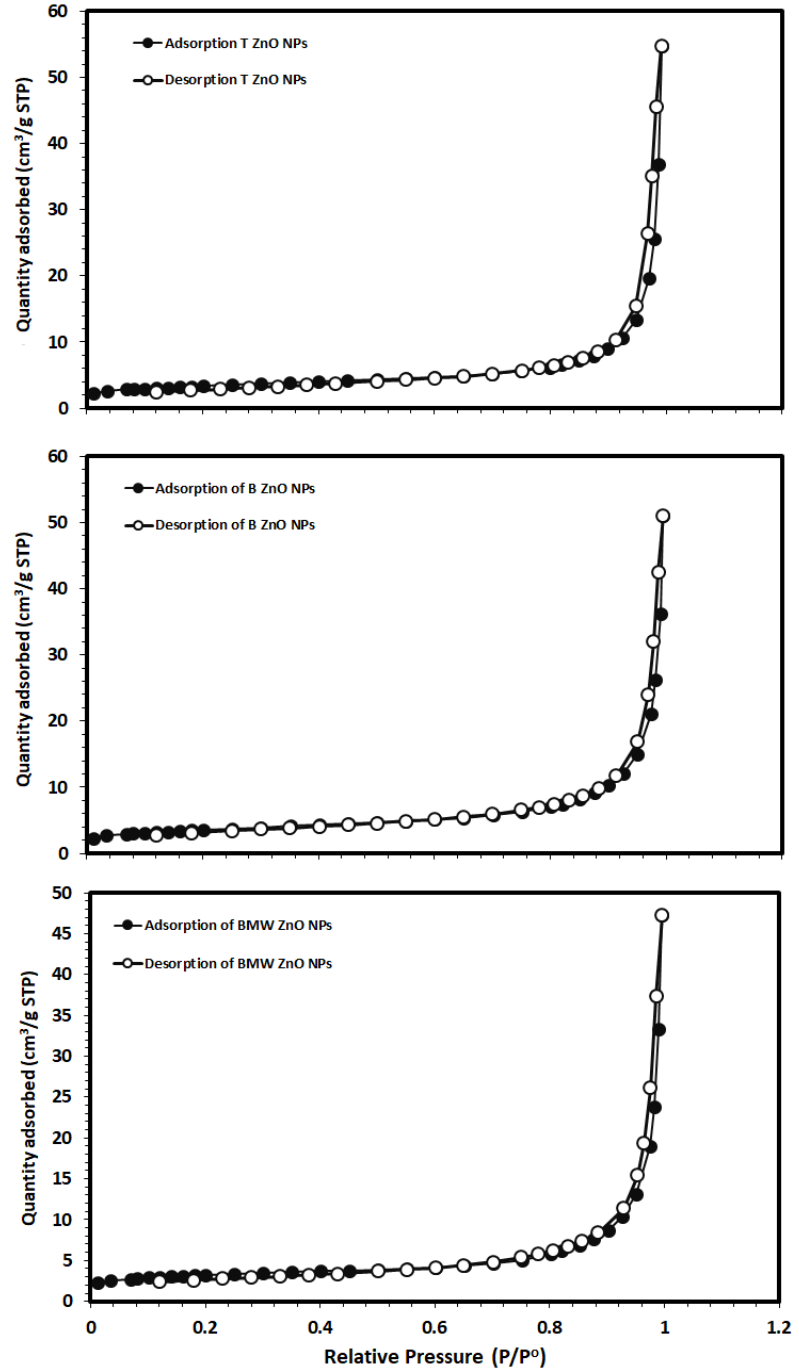
Figure 5. N 2 adsorption/desorption isotherms of different ZnO NPs.